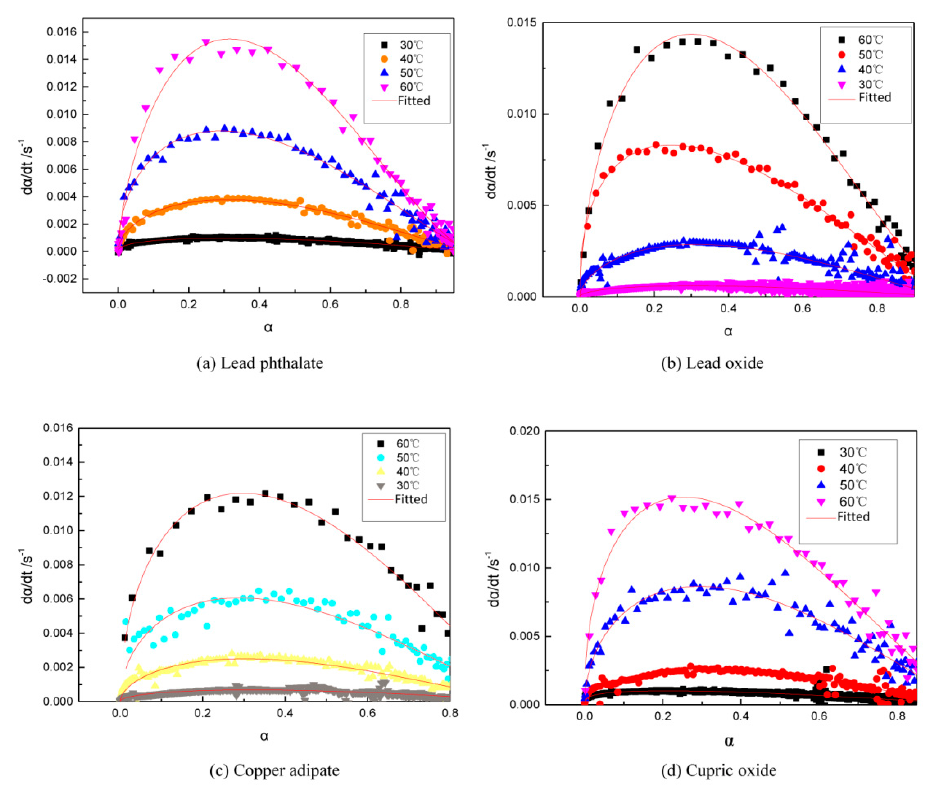
Polymers 2019 , 11 , 637 Figure 8. The conversion speed–conversion rate curve of GAPSPs and its fitted curve. Figure8. The conversion speed–conversion rate curve of GAPSPs and its fitted curve.